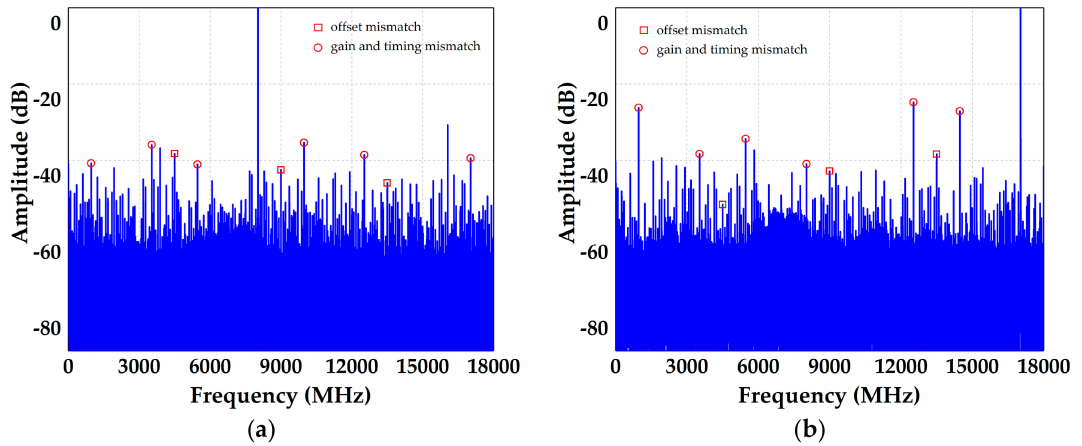
Figure 18. Measured output spectrum ( a ) when fin = 8.1 GHz and ( b ) when fin = 17.1